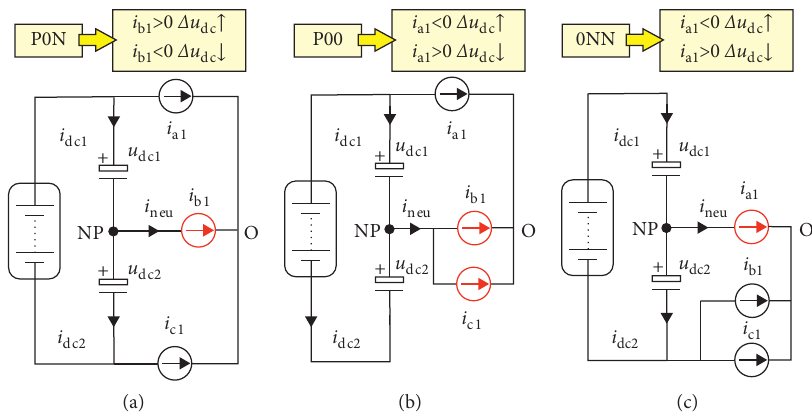
Figure 4: Effects of different vectors on neutral point current. (a) P0N case. (b) P00 case. (c) 0NN case.